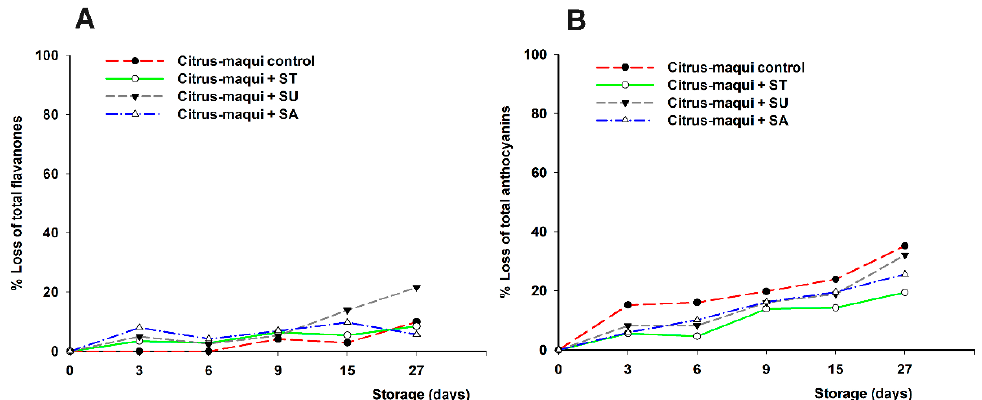
Figure 2. Percentage of loss of total flavanones ( A ) and anthocyanins ( B ) in citrus–maqui beverage samples (control without sweeteners), and citrus–maqui beverage samples plus sweeteners, stevia (ST), sucralose (SU), or sucrose (SA), measured during 27 days at 4 °C. Significantly different final concentration absolute values according to statistical analysis (ANOVA and Tukey’s multiple rank test) were found at p < 0.05, for both figures.